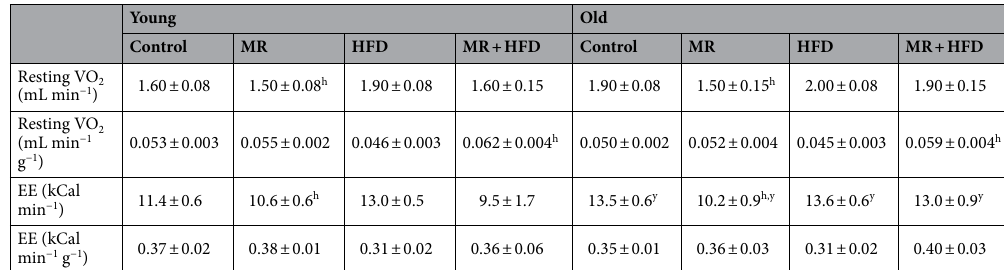
Table 1. Resting oxygen uptake (VO 2 ), resting VO 2 per body mass, energy expenditure (EE) and EE per body mass in young and old mice fed—control, methionine restricted (MR), high fat diet (HFD), or MR + HFD. h Significantly different from HFD at p ≤ 0.012. y Significantly different from young mice at p = 0.025.